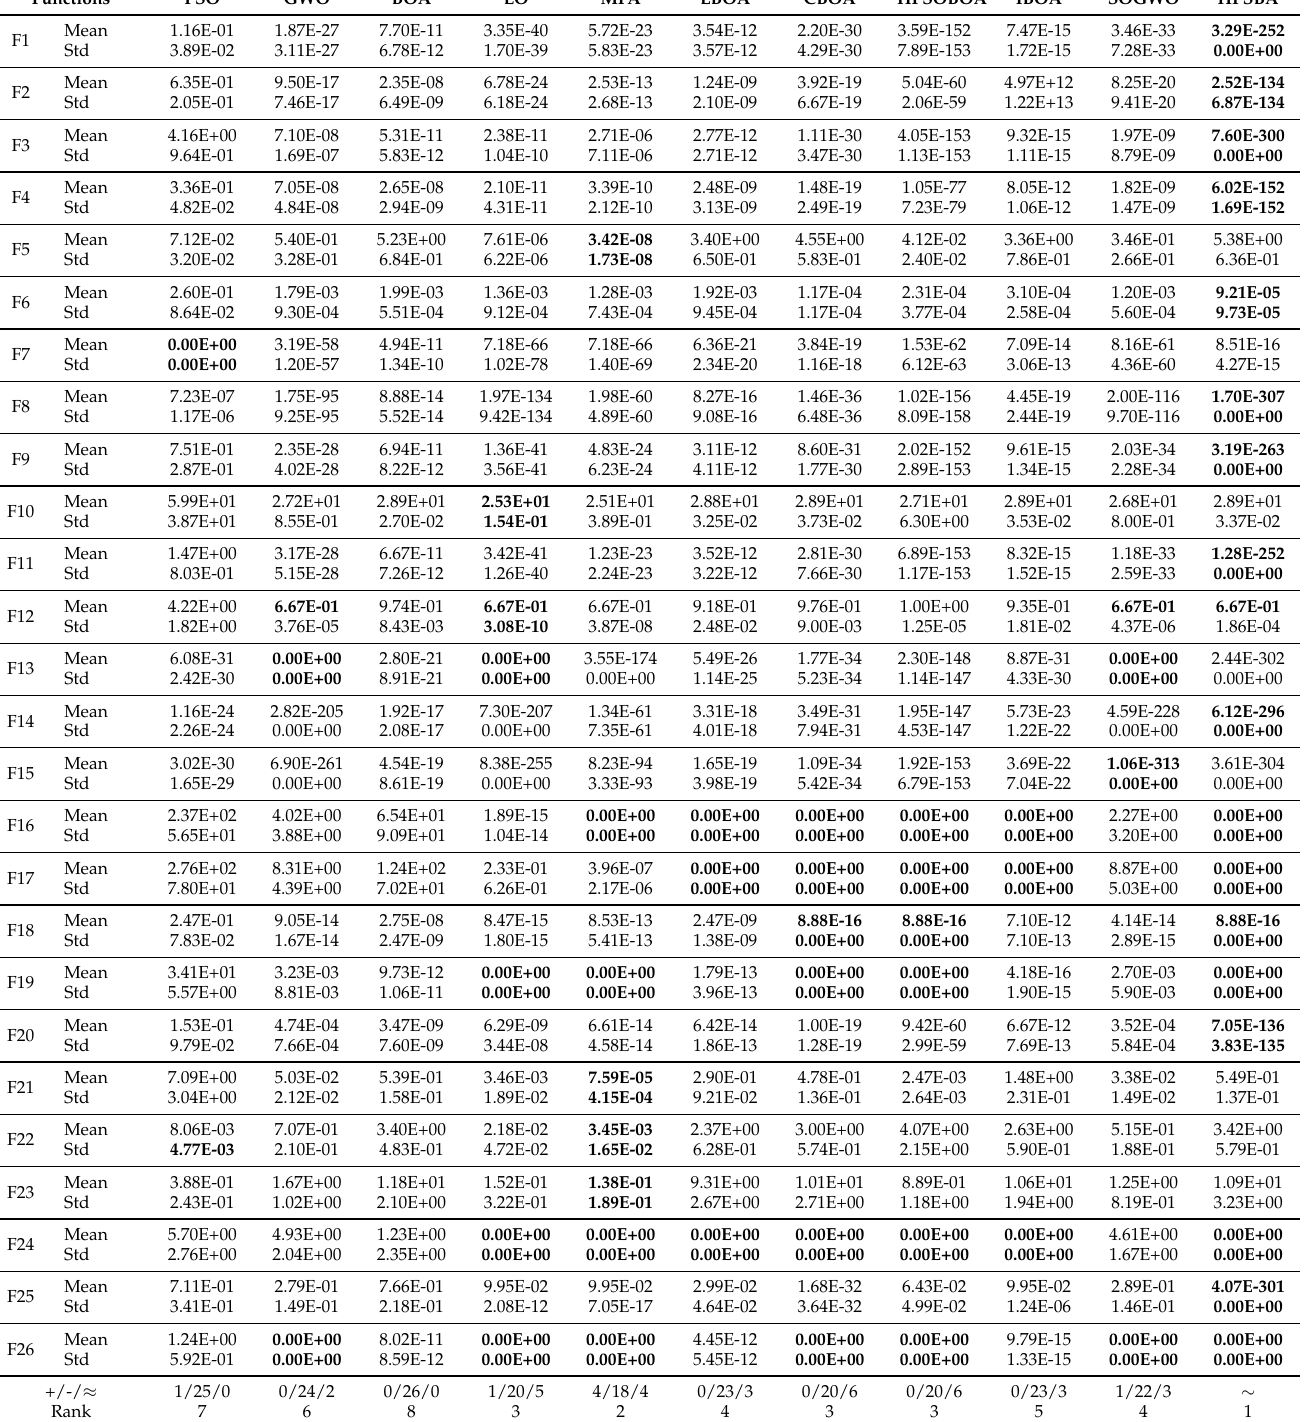
Table 4. Comparison results of eleven algorithms: Dim =